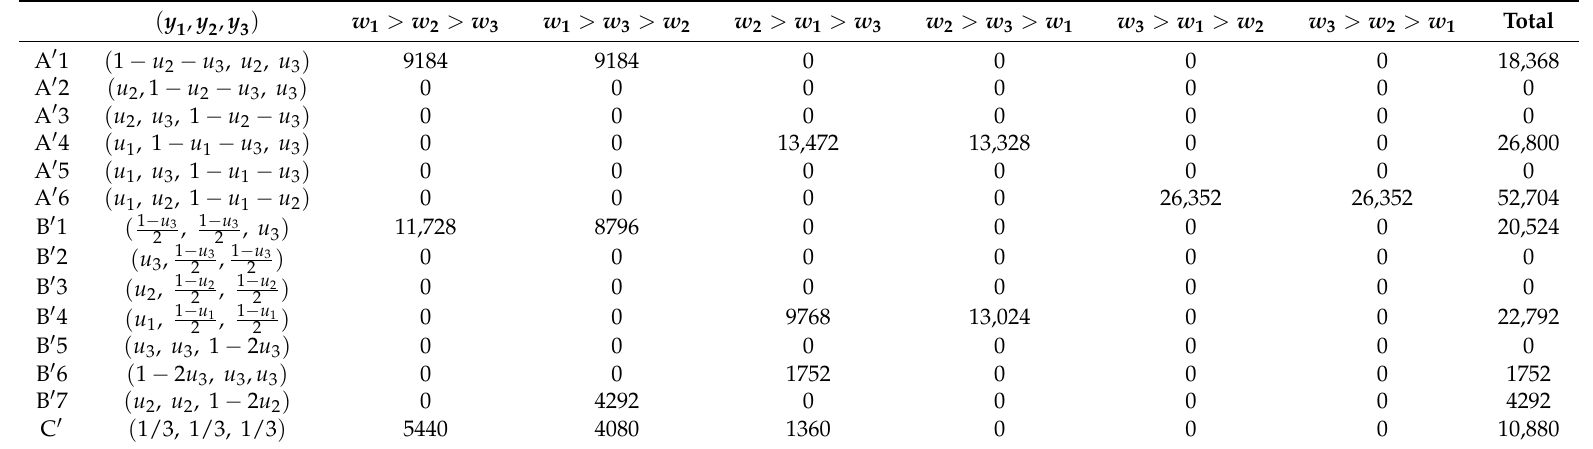
Table 7. The number of instances satisfying solution type and weight for 3COWAU with − 2 ≤ u 3 ≤ u 2 ≤ u 1 ≤